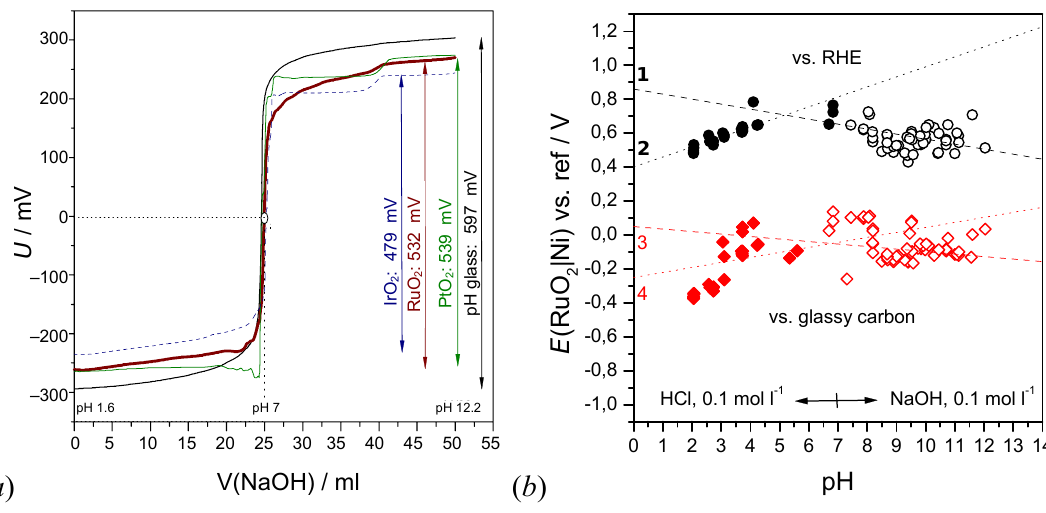
Figure 4. (a) Quasi-stationary potentiometric titration curve of 0.025 molar hydrochloric acid with 0.1 molar sodium hydroxide solution at different metal oxide electrodes (hydrous RuO by alkaline precipitation, bound in alkyd resin; thermal decomposition of H 2 and H PtCl on a nickel support). Counter electrode: glassy carbon. For the purpose of 2 6 comparison, the curves are shifted into the voltage range of a commercial glass